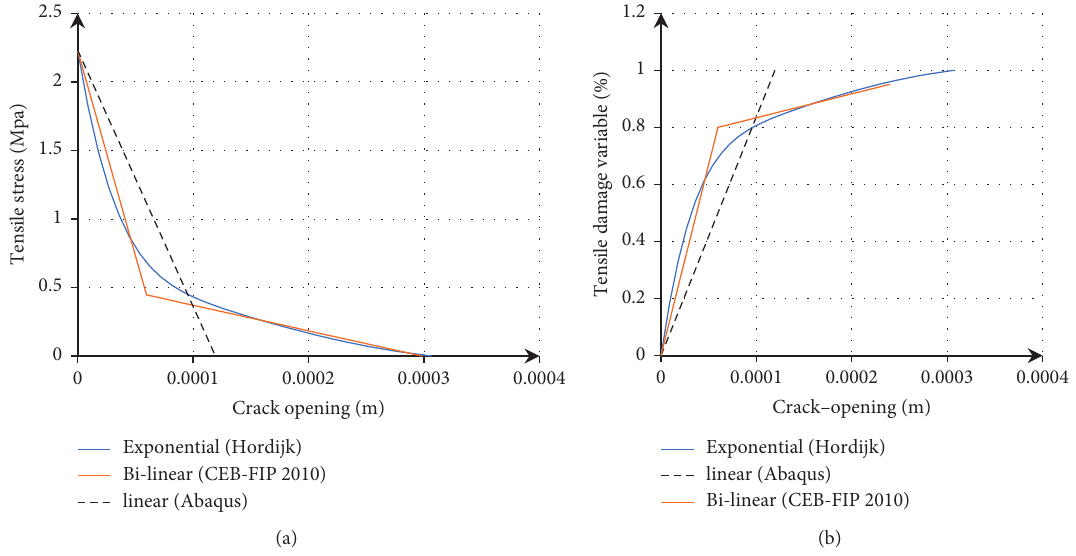
Figure 7: Postfailure concrete tensile behavior. (a) Tensile stress-crack opening curves. (b) Tensile damage versus crack opening curve.